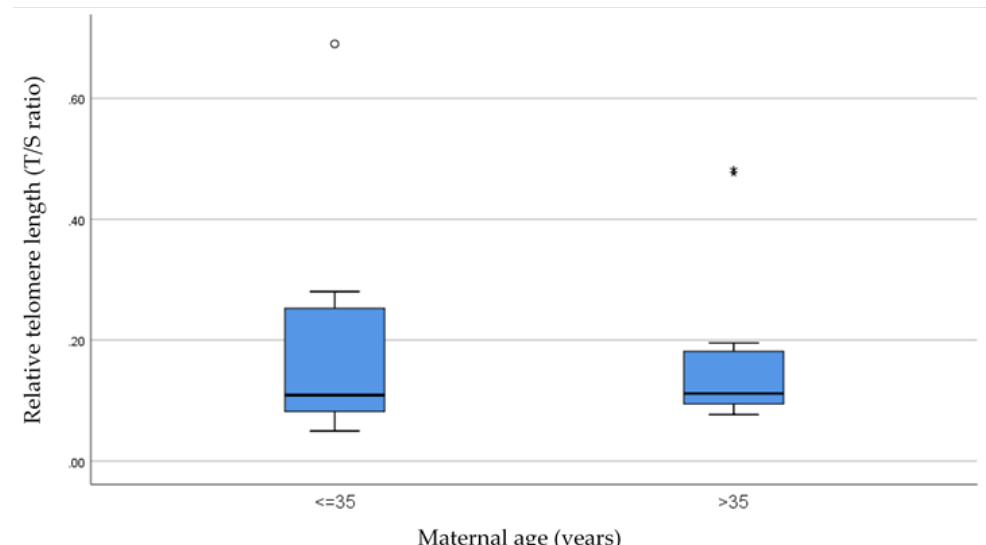
Figure 6. Relative telomere length of euploid first polar bodies in women aged 35 years or younger ( n = 11) in comparison to woman over the age of 35 ( n = 11). Results show no significant difference between the groups ( p = 0.16). The line on the lower end of the whisker represents the minimum T/S ratio, the bottom of the box represents the first quartile, the line through the middle region of the box represents the median T/S ratio, the top of the box represents the third quartile, and the line at the top of the whisker represents the maximum T/S ratio. Circles represent outliers between 1.5 and 3 box lengths from the upper region of the box. Asterisks represent extreme outliers that are more than three times the interquartile range from the 3rd